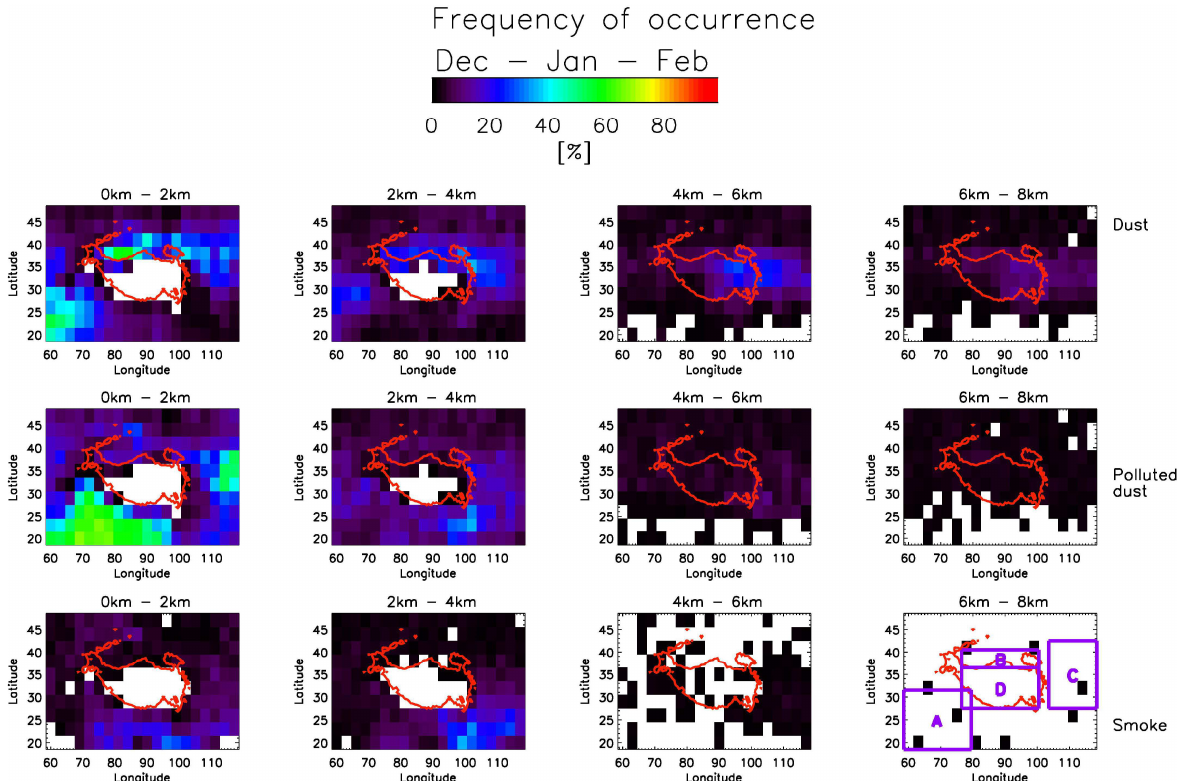
Fig. 1. Aerosol frequency of occurrence for the DJF season. Different aerosol types (dust, polluted dust, smoke) are reported from top to bottom. Different vertical layers are reported from left to right. White shades indicate absence of aerosol layers. In the right bottom the violet boxes highlight the four subregions that will be considered in the interannual analysis (see Sect.